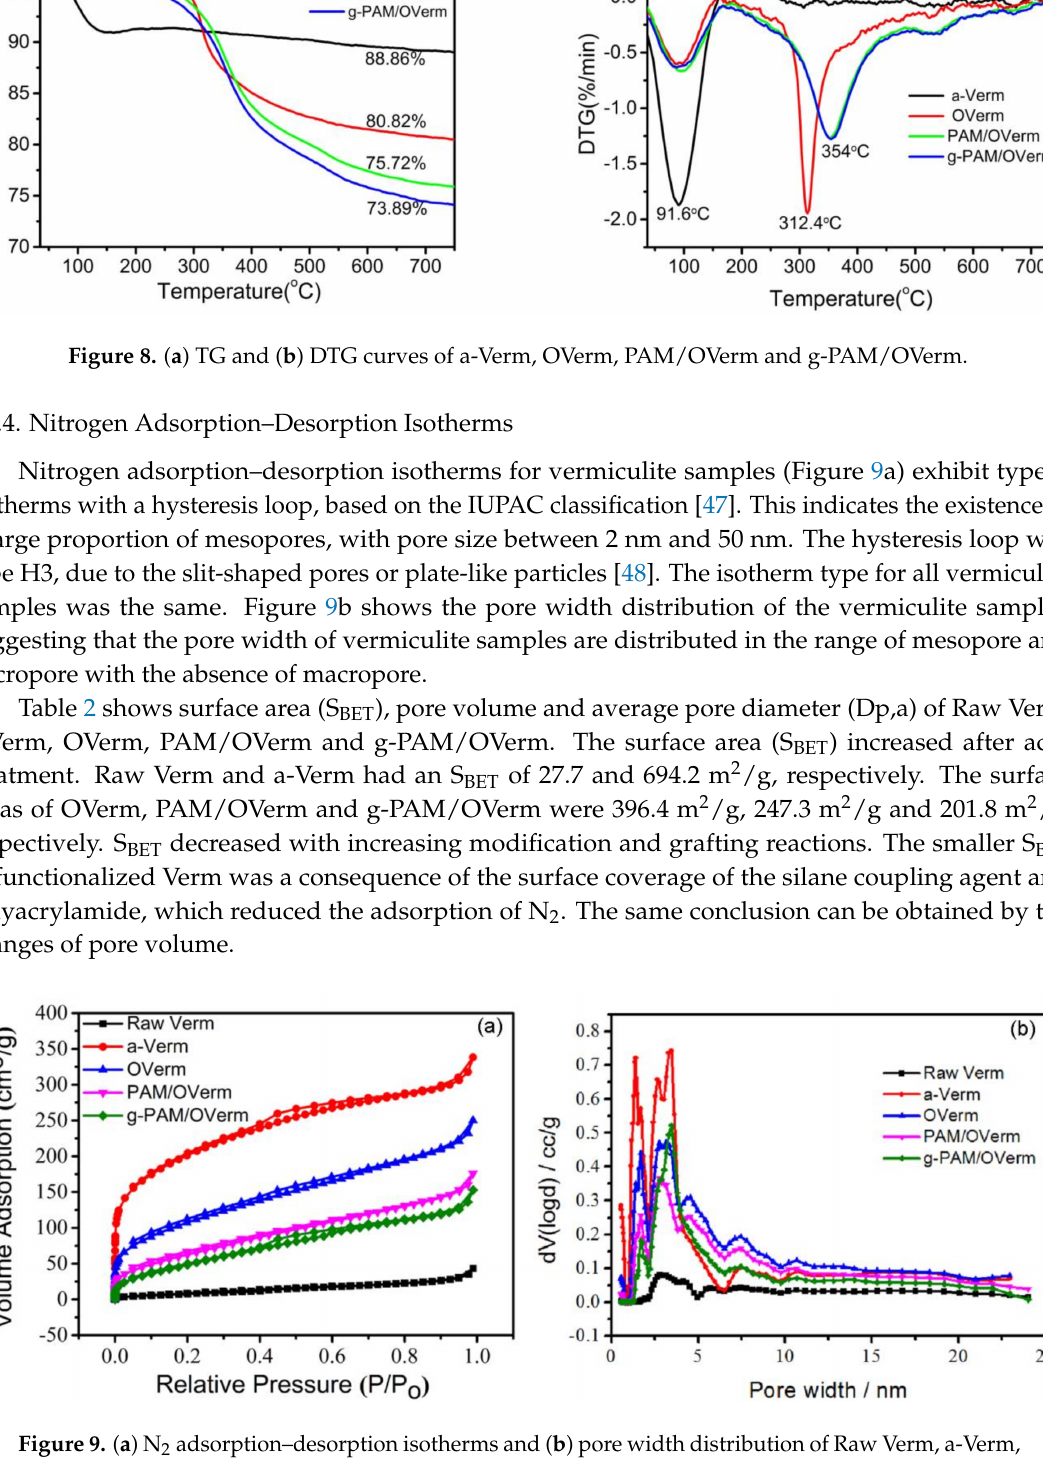
Figure 9. ( a ) N 2 adsorption–desorption isotherms and ( b ) pore width distribution of Raw Verm, a-Verm, OVerm, PAM/OVerm and